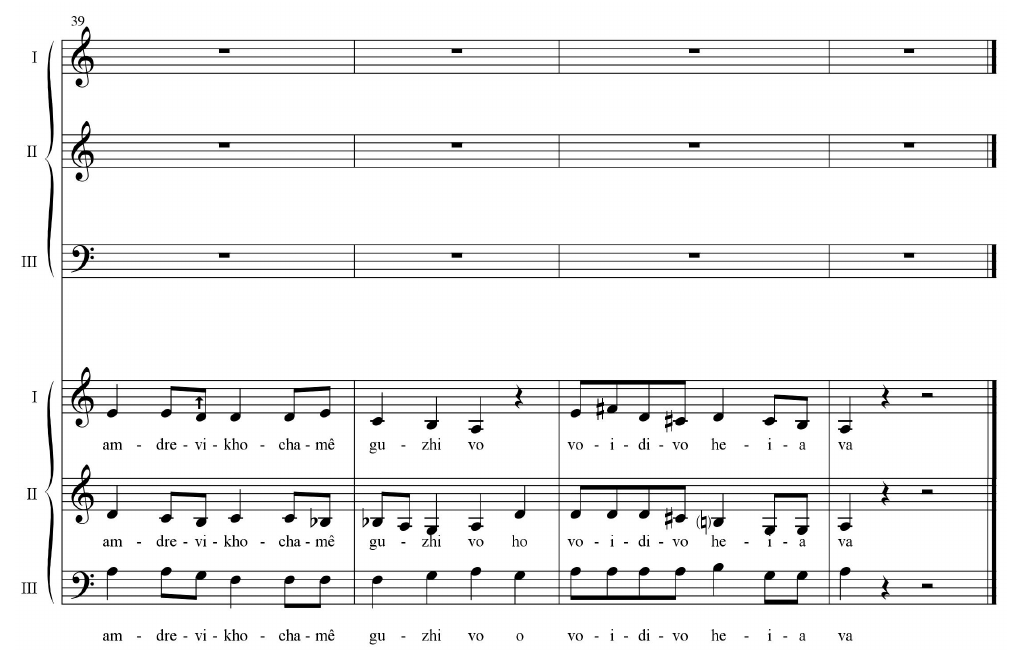
Figure 23. Didebata; Svan round-dance to the Archangels, Lakhushdi variant.